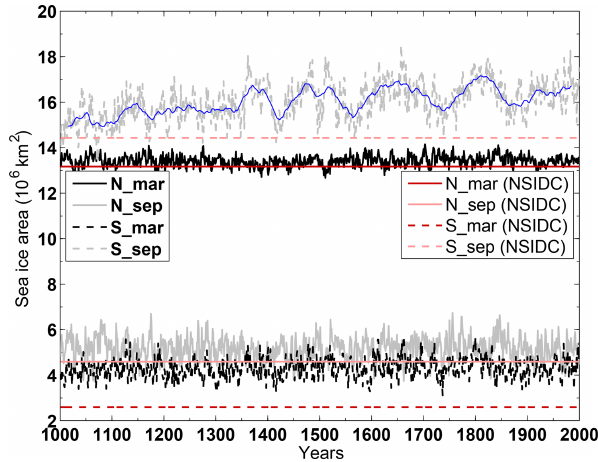
Figure 3. Time series of sea ice area (10 6 km 2 ) in the Northern Hemisphere and Southern Hemisphere for September and March. Black and grey lines are from the PI control experiment, and red lines are from National Snow and Ice Data Center (NSIDC) ob- servations (Fetterer et al., 2016). The blue line is the 30-year run- ning mean of the simulated Southern Hemisphere September sea ice